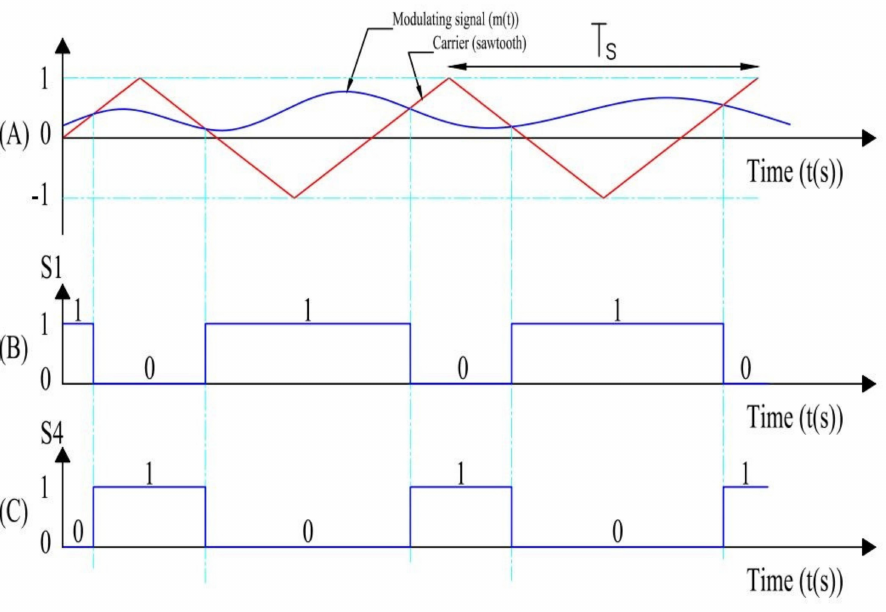
Figure 23. The signal depends on the PWM operation technology: ( A ) Modulation signal and carrier signal; ( B ) S1 switching function; ( C ) S4 switching